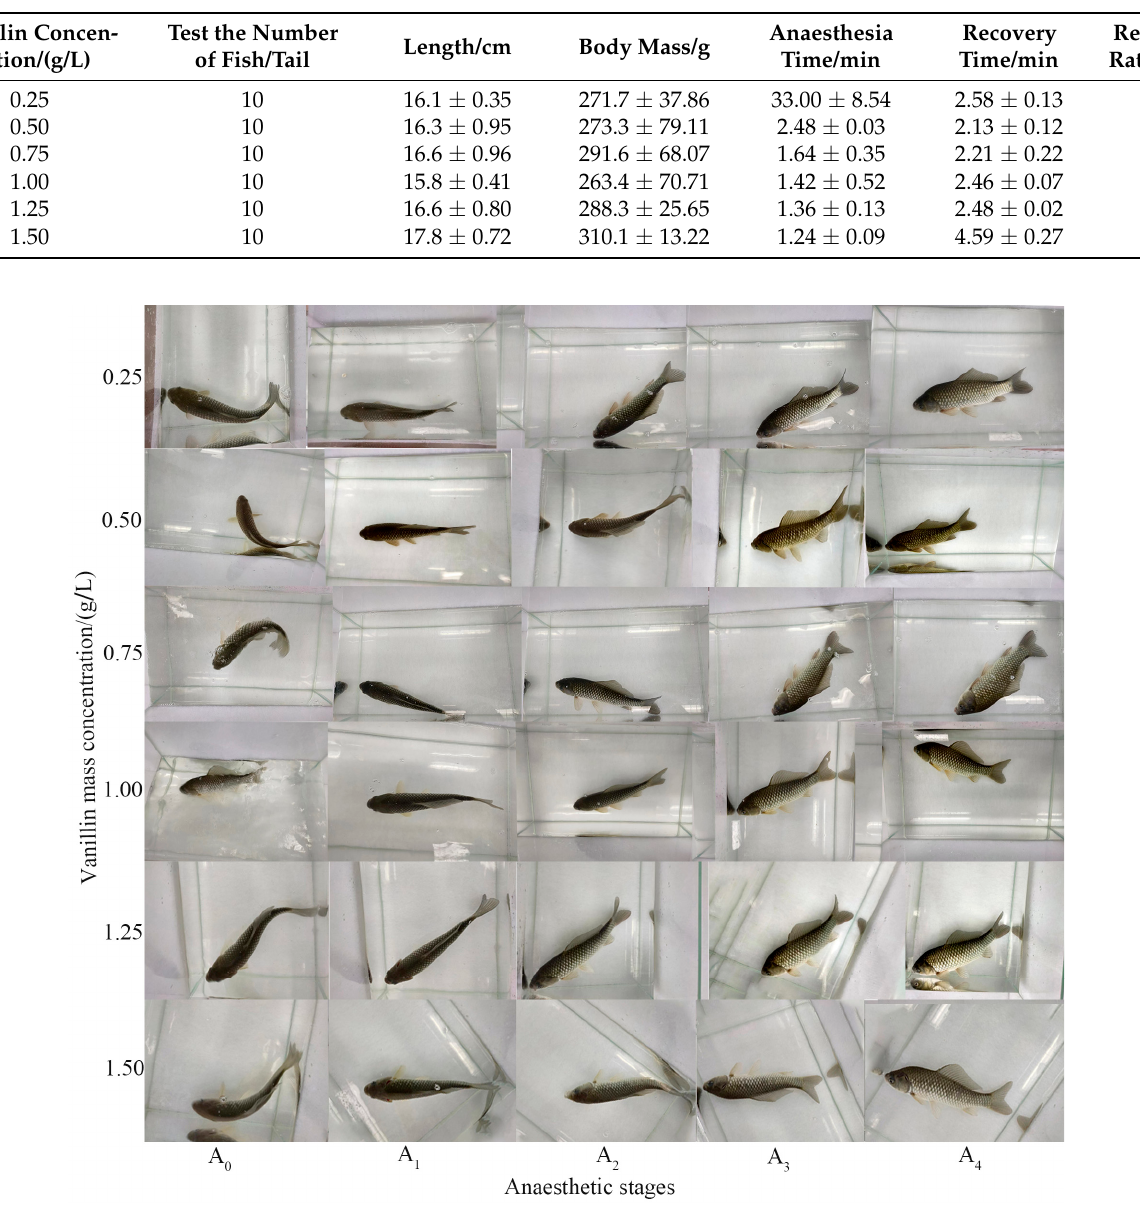
Table 2. Effect of different vanillin concentrations on the time taken to achieve anaesthesia and time taken for complete recovery for crucian carp.